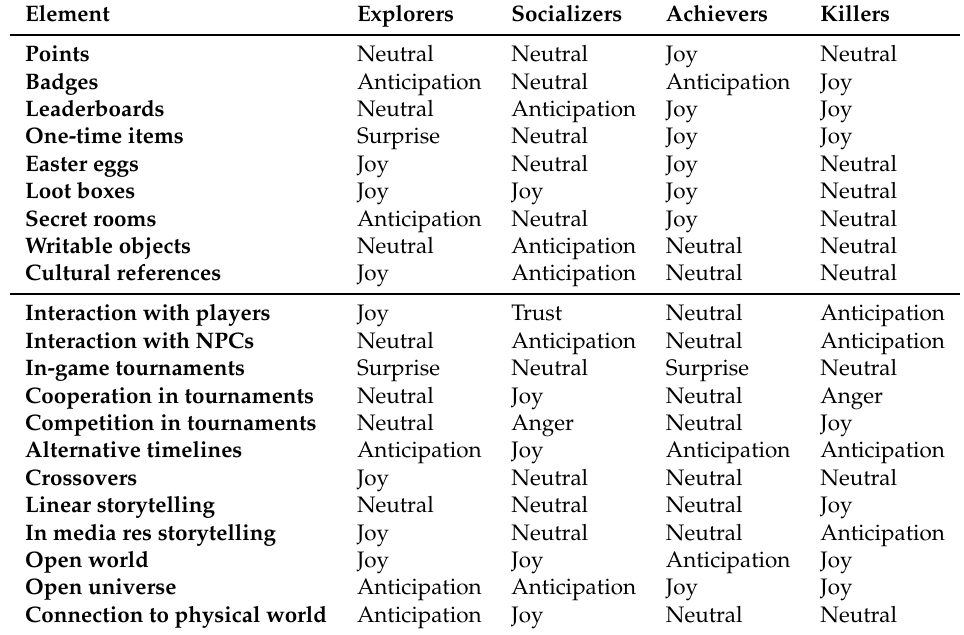
Table 2. Emotions triggered by low-(upper half) and high-level (lower half) elements (Source: See text). Element Explorers Socializers Achievers Killers Points Neutral Neutral Joy Neutral Badges Anticipation Neutral Anticipation Joy Leaderboards Neutral Anticipation Joy Joy One-time items Surprise Neutral Joy Joy Easter eggs Joy Neutral Joy Neutral Loot boxes Joy Joy Joy Neutral Secret rooms Anticipation Neutral Joy Neutral Writable objects Neutral Anticipation Neutral Neutral Cultural references Joy Anticipation Neutral Neutral Interaction with players Joy Trust Neutral Anticipation Interaction with NPCs Neutral Anticipation Neutral Anticipation In-game tournaments Surprise Neutral Surprise Neutral Cooperation in tournaments Neutral Joy Neutral Anger Competition in tournaments Neutral Anger Neutral Joy Alternative timelines Anticipation Joy Anticipation Anticipation Crossovers Joy Neutral Neutral Neutral Linear storytelling Neutral Neutral Neutral Joy In media res storytelling Joy Neutral Neutral Anticipation Open world Joy Joy Anticipation Joy Open universe Anticipation Anticipation Joy Joy Connection to physical world Anticipation Joy Neutral